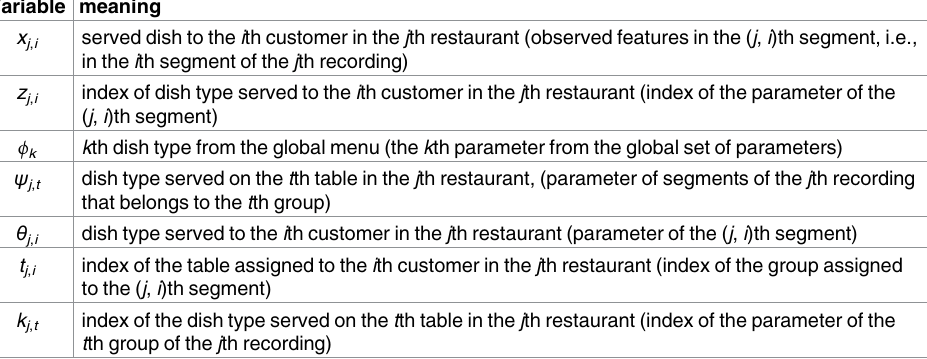
Table 1. Meaning of the variables of the HDP process and their relationship to the FHR classification problem. Variable